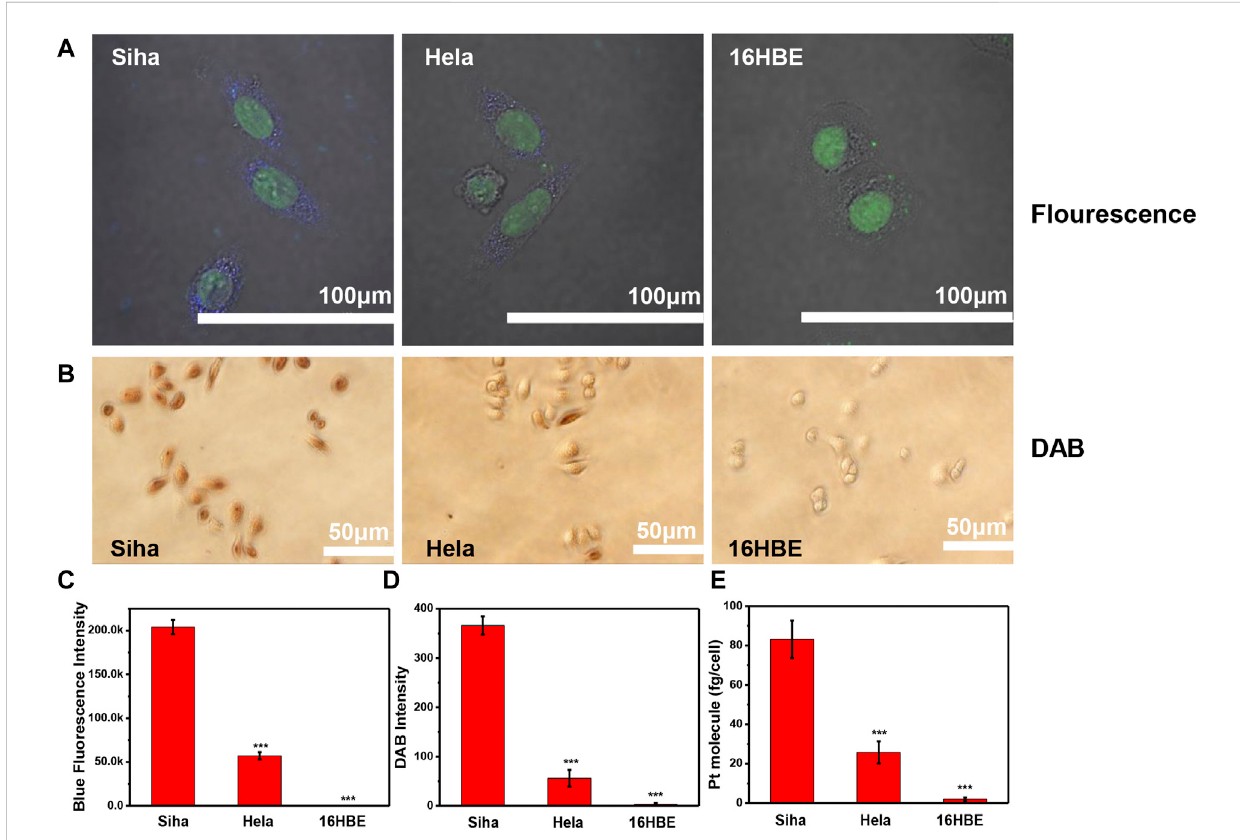
Detecting the expression level of α v β 3 among different cell lines. SiHa, HeLa, and 16HBE cells were exposed to 120 μ M Pt clusters for 60 min (A) CLSM system imaging. (B) Images of the brown DAB dyed cells. (C) Corresponding fl uorescence intensity analyzed by ImageJ software. (D) Corresponding brown intensity analyzed by ImageJ software. (E) Pt element content in the cell after cells were treated with Pt